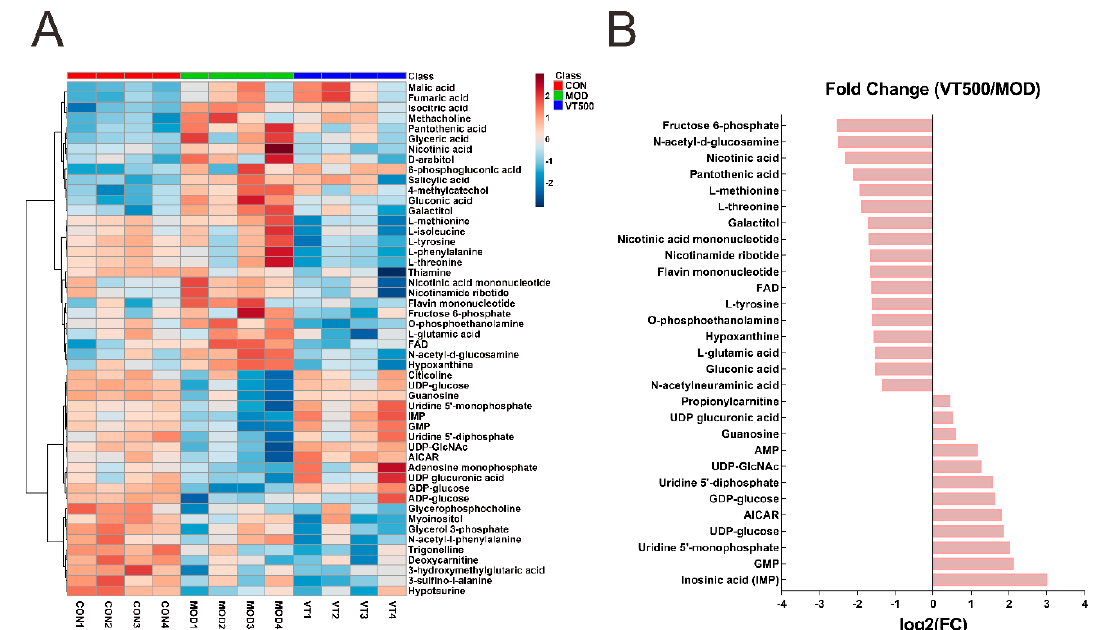
Figure 4. Effects of VT on the concentration of liver metabolites in rats. The heatmap of the 50 most impacted hepatic metabolites among the CON, MOD and VT500 groups ( A ); analysis of the changes in the content of 29 key hepatic metabolites ( p < 0.05) between the VT500 group and MOD group ( B ).